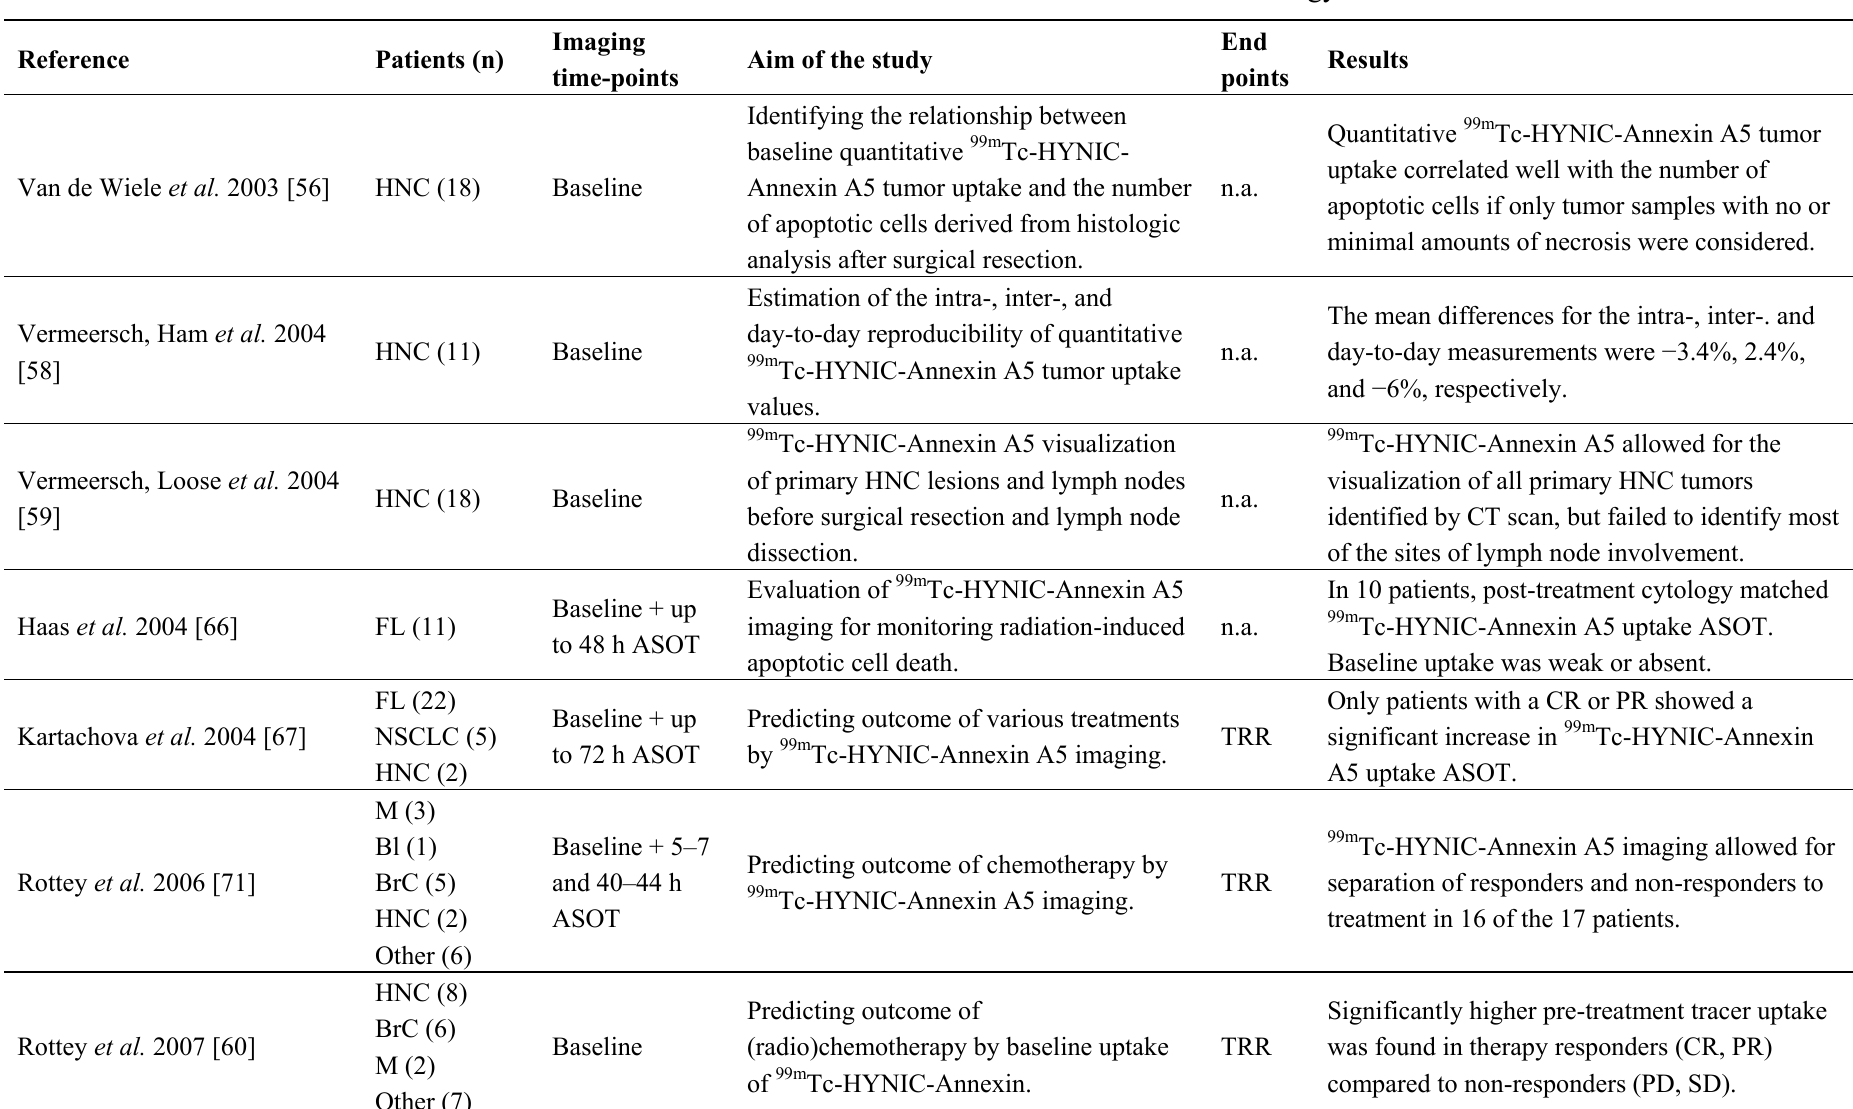
Table 2. Clinical studies of 99m Tc-HYNIC-Annexin A5 in